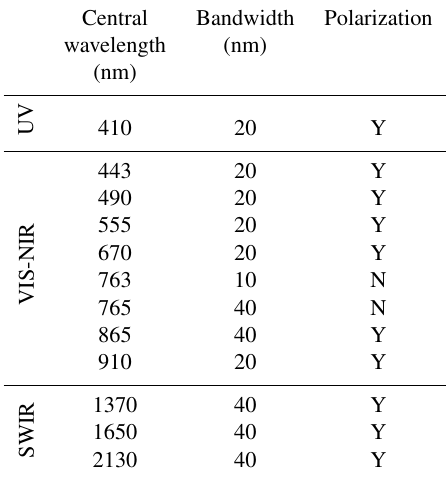
Table 1. Future 3MI spectral